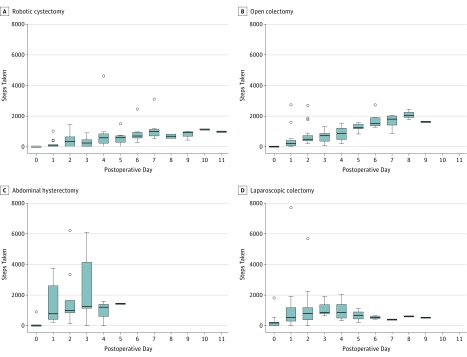
Digitally Monitored Step Count by Postoperative Day and Operation TypeBoxes show the first quartile (lower border of the box), median (thick horizontal line within the box), and third quartile (top border of the box). Whiskers extending from the top and bottom borders of the box show the range of nonoutlier values. The individual points outside the whisker boundaries indicate outlier values that are less than the first quartile or greater than the third quartile by 1.5 times the interquartile range.